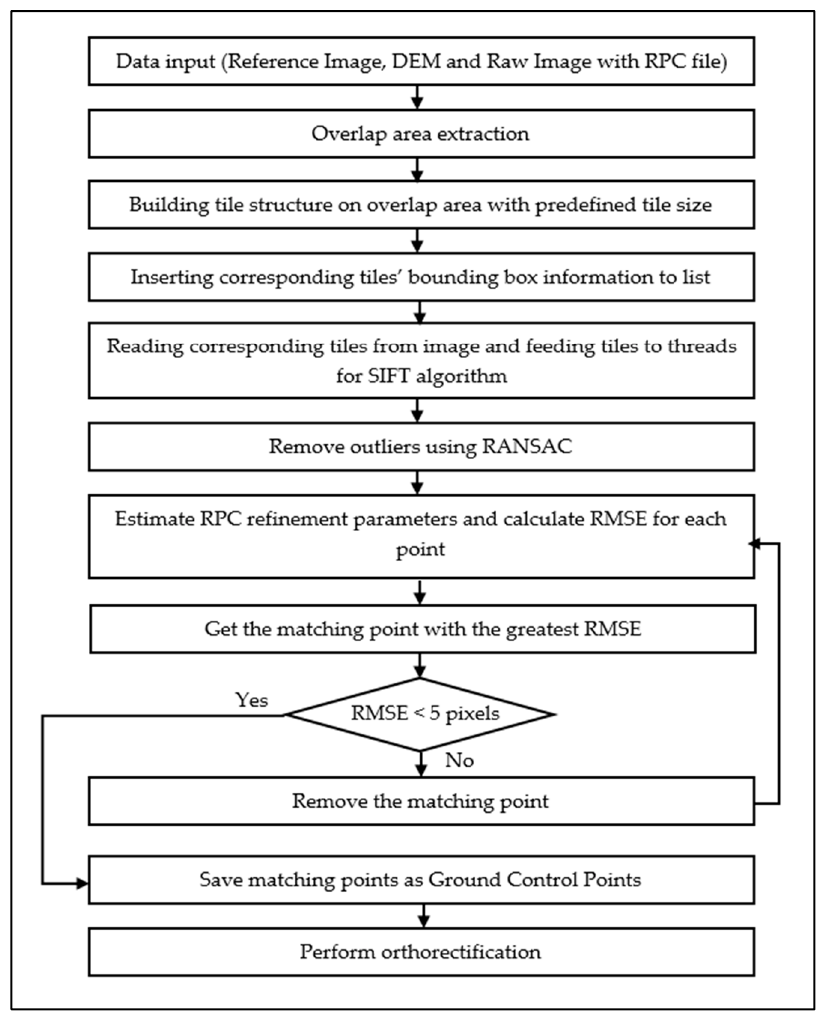
Figure 4. Diagram of the Scale Invariant Feature Transform (SIFT)-based automated orthorectification.